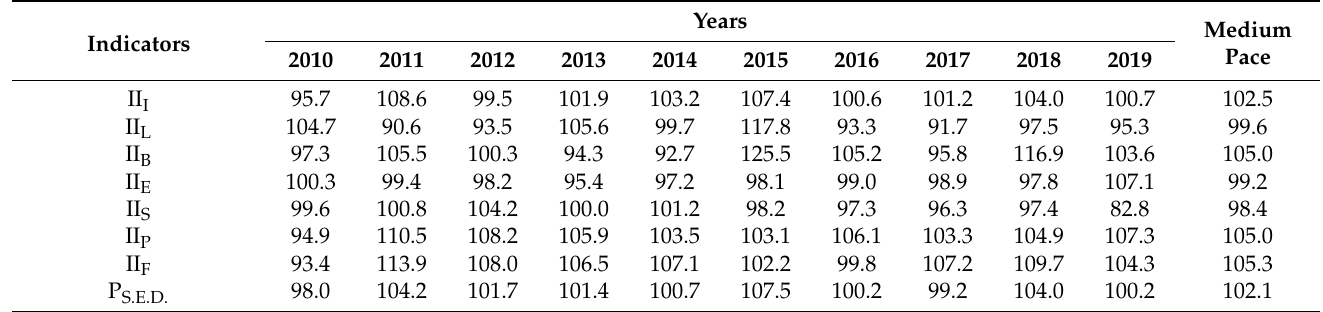
Table 15. The pace of socio-economic development in the Russian Federation in 2010–2019,